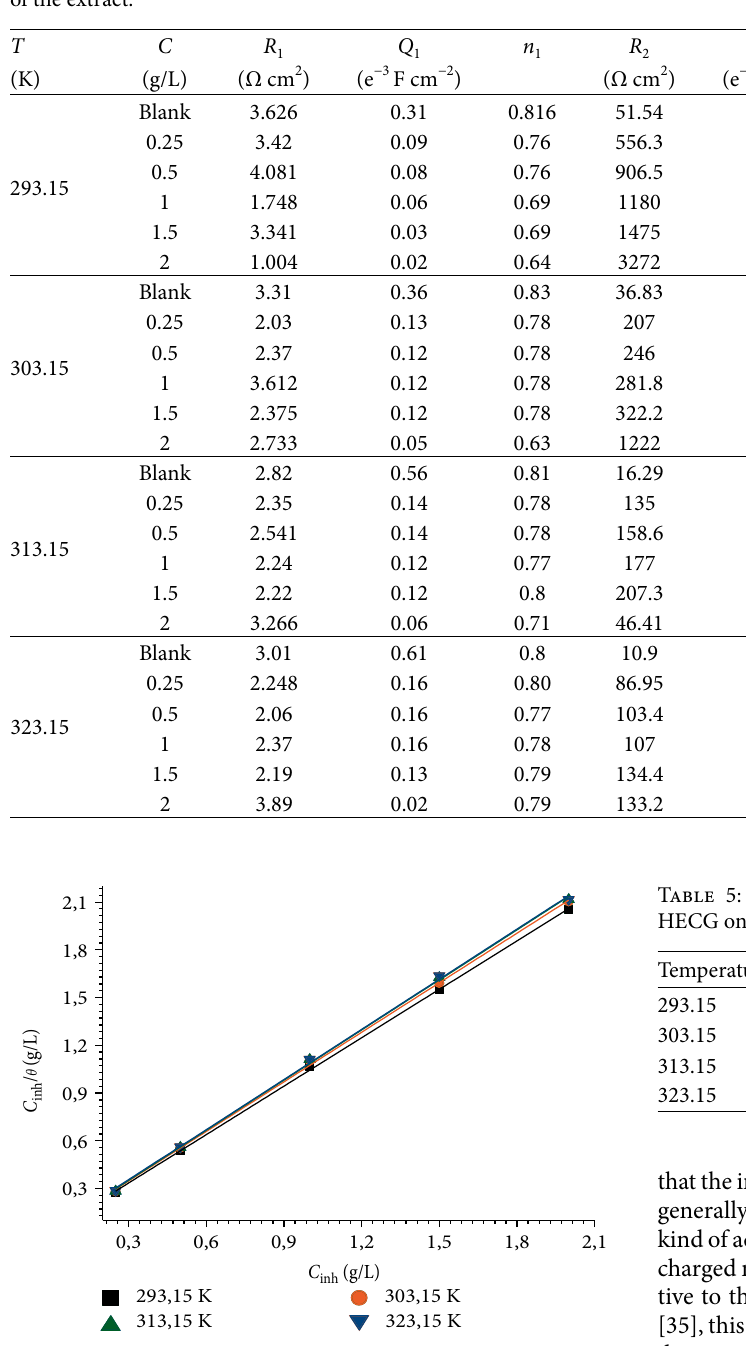
Figure 7: Langmuir adsorption isotherm of HECG on C38 steel in 1 M HCl at different temperatures.